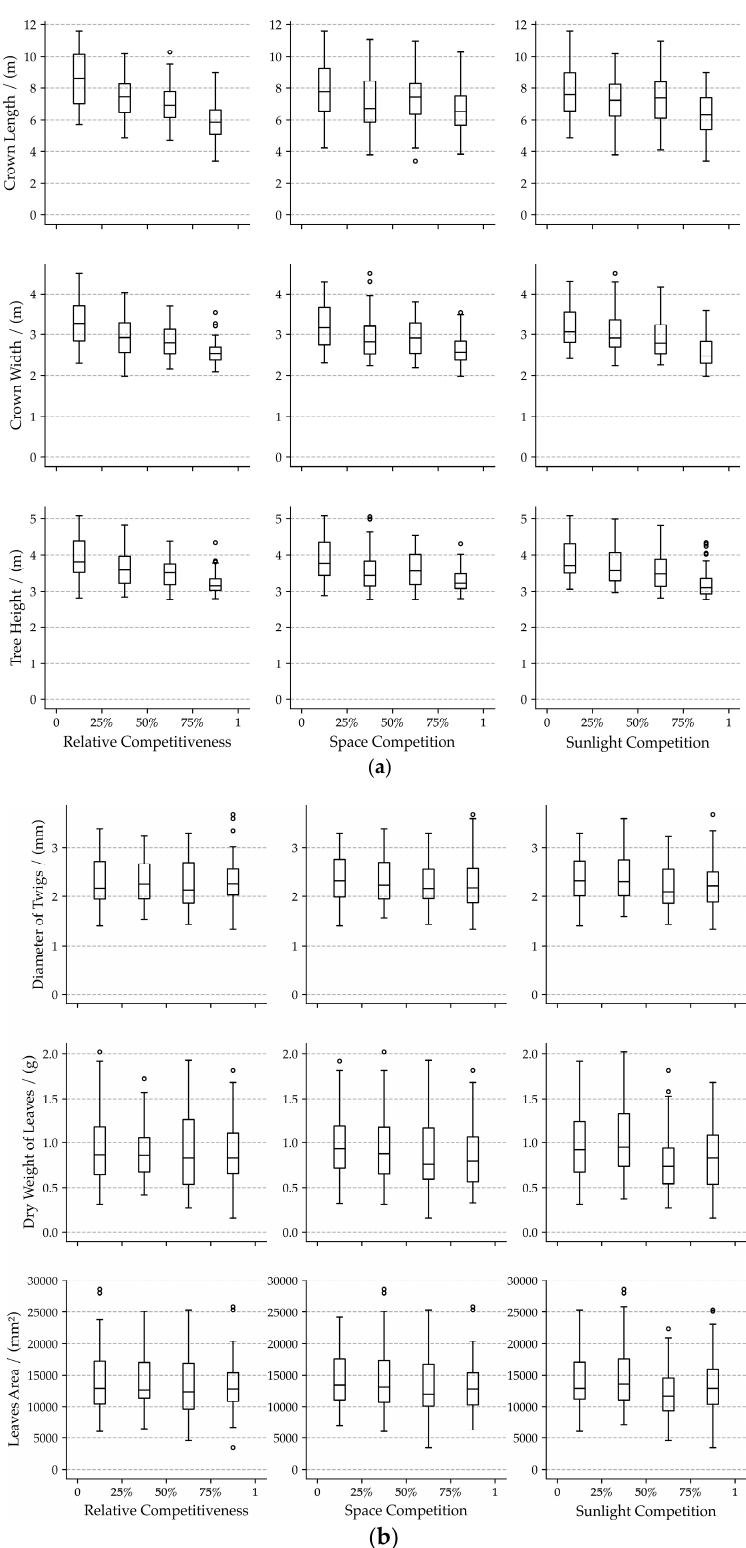
Figure 4. Box-plots of crown form traits ( a ) and foliage form traits ( b ) for each neighboring competition indicator. In the subplots, 25%, 50%, and 75% indicate the lower quartile, median, and upper quartile of each neighboring competition indicator.